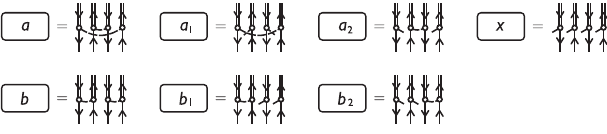
FIG. 14. Contractions in a portion of a site diagram for